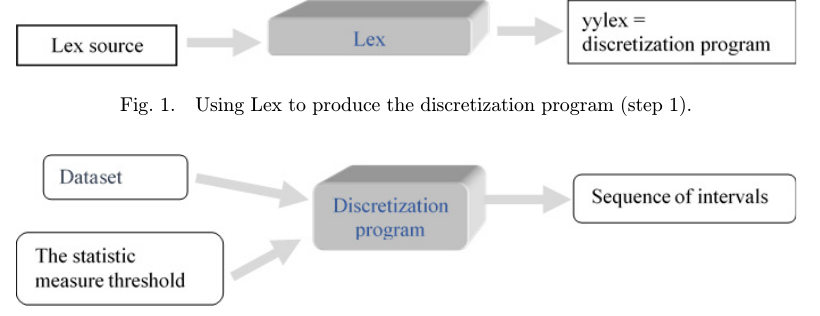
Fig. 2. Executing the discretization program for yielding the sequence of intervals (step